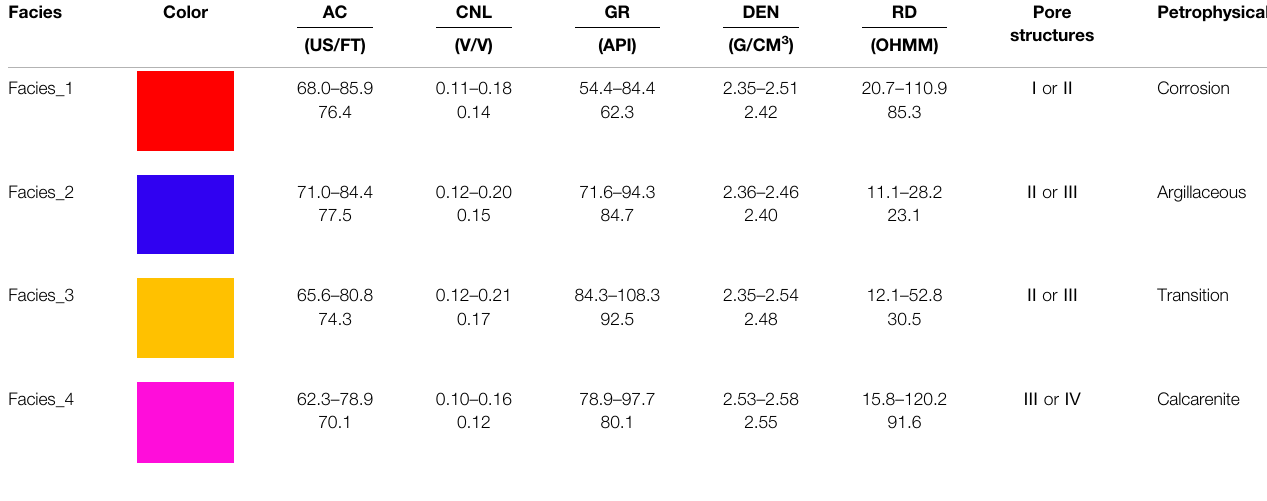
TABLE 4 | Typical characteristics of different petrophysical facies in the Es 3